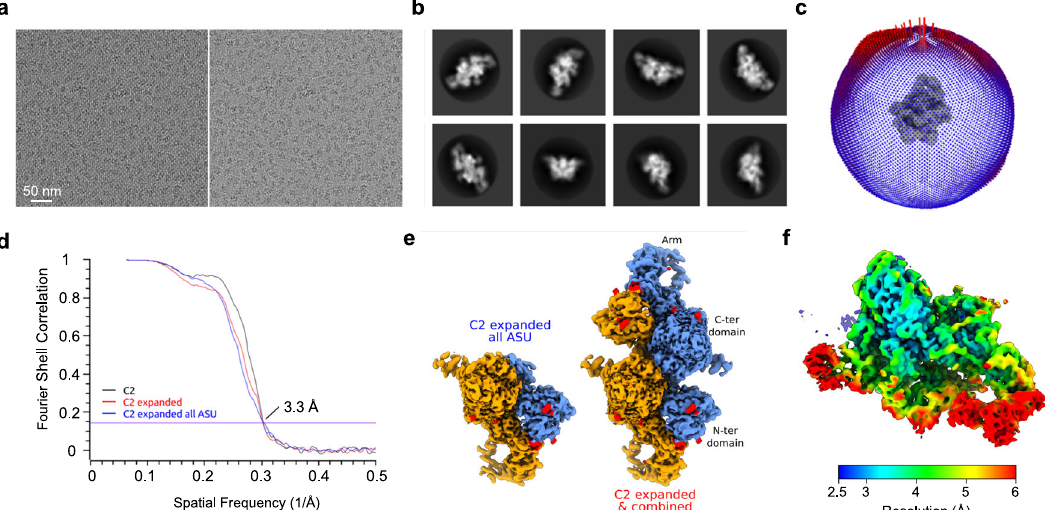
Fig. 2 Cryo-EM analysis of native bovine TG. a Cryo-EM micrographs of biotinylated TG particles captured on a streptavidin af fi nity grid. Left, micrograph illustrating particles bound to the streptavidin 2D crystal lattice (5-nm array). Scale bar is at lower left. ( N = 34,597). Right, the same image after subtraction of the lattice by Fourier fi ltering of Bragg spots 8 . b 2D class averages. c Angular distribution of TG particles. Blue-to-red color gradient marks under-to-over-represented orientations. d FSC curves showing the correlation between the indicated independent half-maps. e Reconstructions of native bovine TG from the indicated data processing procedures. Monomer subunits are colored blue and orange, respectively. N-linked glycosylation sites, red. f Unsharpened density map colored by local resolution (ranges from ~2.7 Å to 8.75 Å).